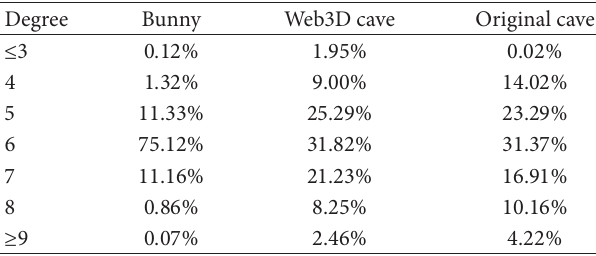
Table 6: Frequency of vertex degrees for the tested models.